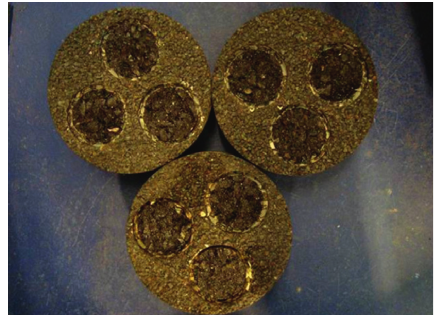
Figure 27: Fracture energy density for PAV-aged binders [145]. Note: NA � neat asphalt; SBS � SBS-modified asphalt; CRA � - crumb rubber modified asphalt; HVA � high viscosity asphalt; EA � epoxy asphalt.